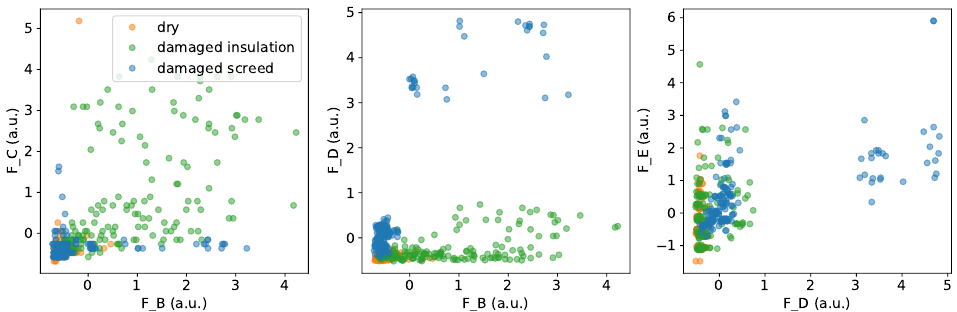
Figure 15. Scatter plots showing the feature combination of F B & F C ( left ), F B & F D ( middle ) and F D & F E ( right